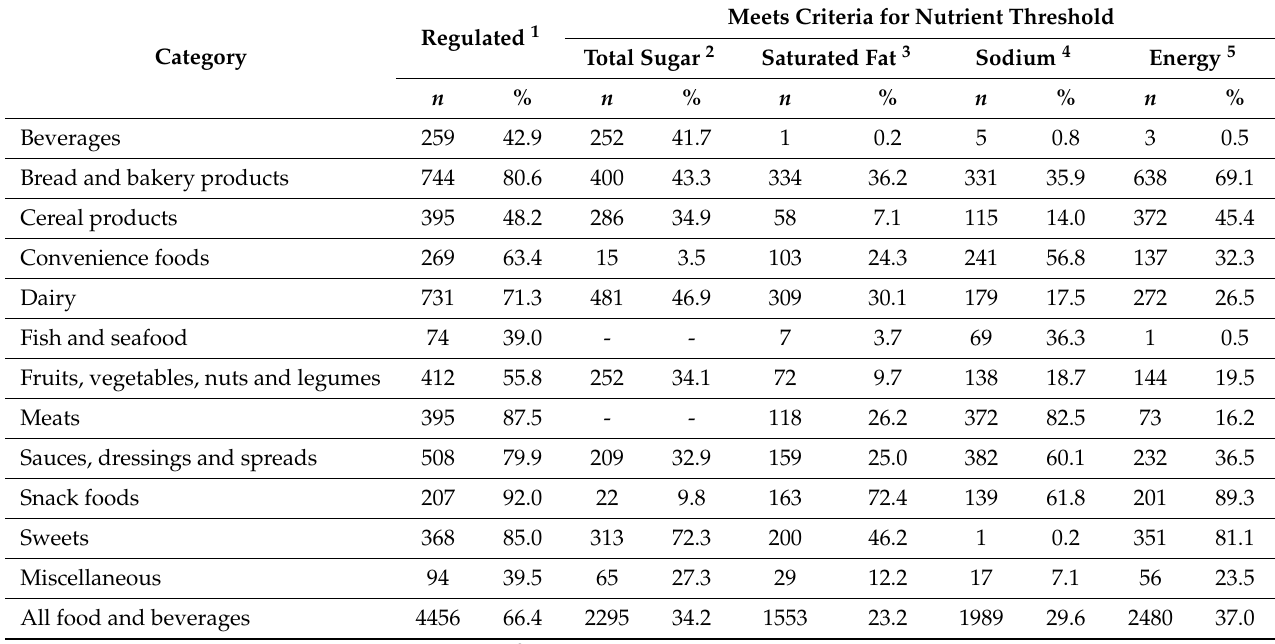
Table 3. Number and proportion of packaged food and beverage products meeting the criteria for regulation under the Chilean model, by food category. Meets Criteria for Nutrient Regulated 1 Category